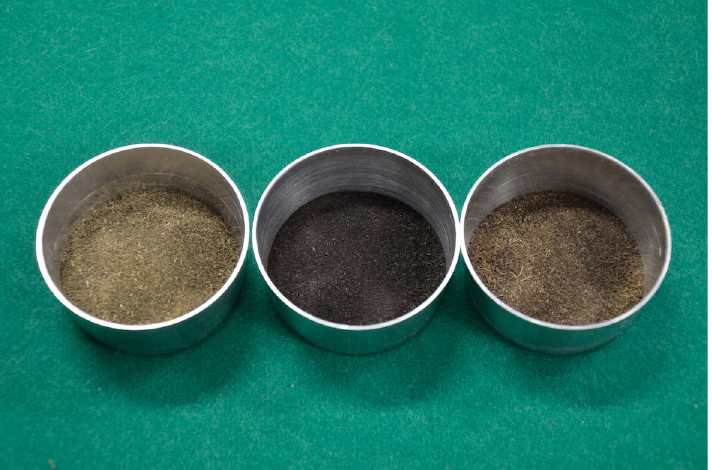
Fig 2. Appearance of raw dairy manure (left), manure treated under air at 90 ˚C (center), and manure treated under